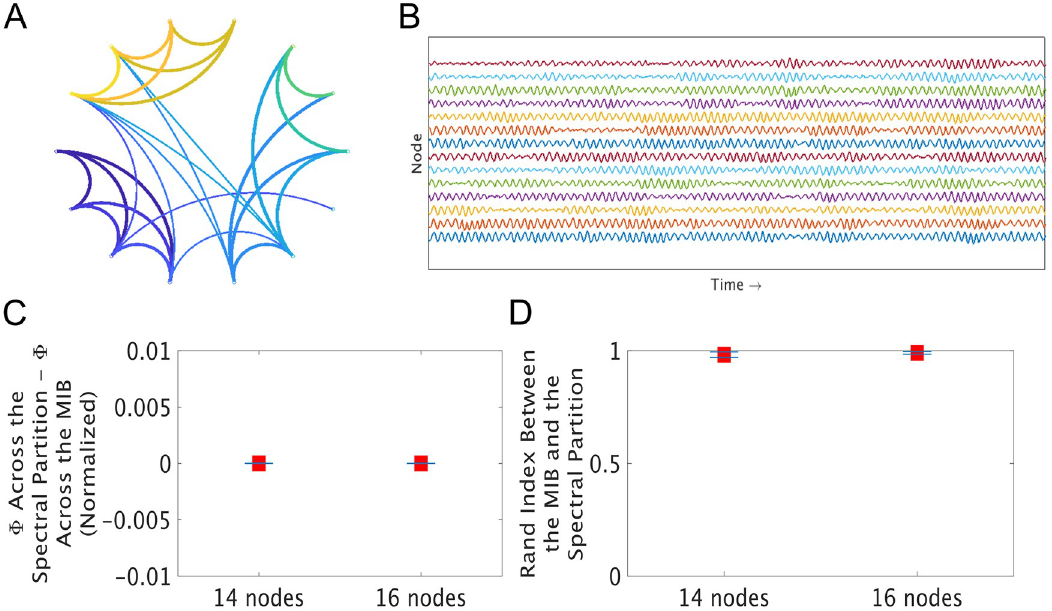
Fig 2. We first tested our spectral clustering-based approach in small simulations. A This is an example of a small brain-like network we generated using a novel algorithm based on Hebbian plasticity. This algorithm produces networks that are loosely brain- like, in that they are modular, show rich cross-module connectivity, and display a log-normal degree distribution with long right tails. We used this algorithm to generate 50 14- and 16-node networks. see Methods for more details on network generation. B This is a sample of oscillatory data generated from the network in A . We generated these data using a stochastic coupled Ro¨ssler oscillator model. In the Ro¨ssler oscillator model, each node stochastically oscillates according to its own intrinsic frequency, and dynamically synchronizes with other nodes it is connected to. The resulting data are multivariate normal (S2 Fig), allowing for the fast computation of integrated information. C As a first test of our spectral clustering-based approach to identifying the MIB from time- series data, we subtracted F G (normalized) across the ground-truth MIB, identified through a brute-force search through all possible bipartitions, from F G (normalized) across the partitions identified through spectral clustering. In this test, a perfect match between values would yield a difference of 0 bits. Red squares indicate the mean across 50 networks, and the blue bars indicate standard error of the mean. D As a second test of our spectral clustering-based approach, we computed the Rand Index [45], which is a common measure of partition similarity, between the spectral partitions and the ground-truth MIBs of these networks. A Rand Index of 1 indicates a perfect match between partitions, and a Rand Index of 0 indicates maximum dissimilarity between partitions. Red squares indicate the mean across 50 networks, and the blue bars indicate standard error of the mean. These results show that spectral clustering finds the MIB of small networks of coupled oscillators. We found similar results using the same networks but with autoregressive network dynamics (S7